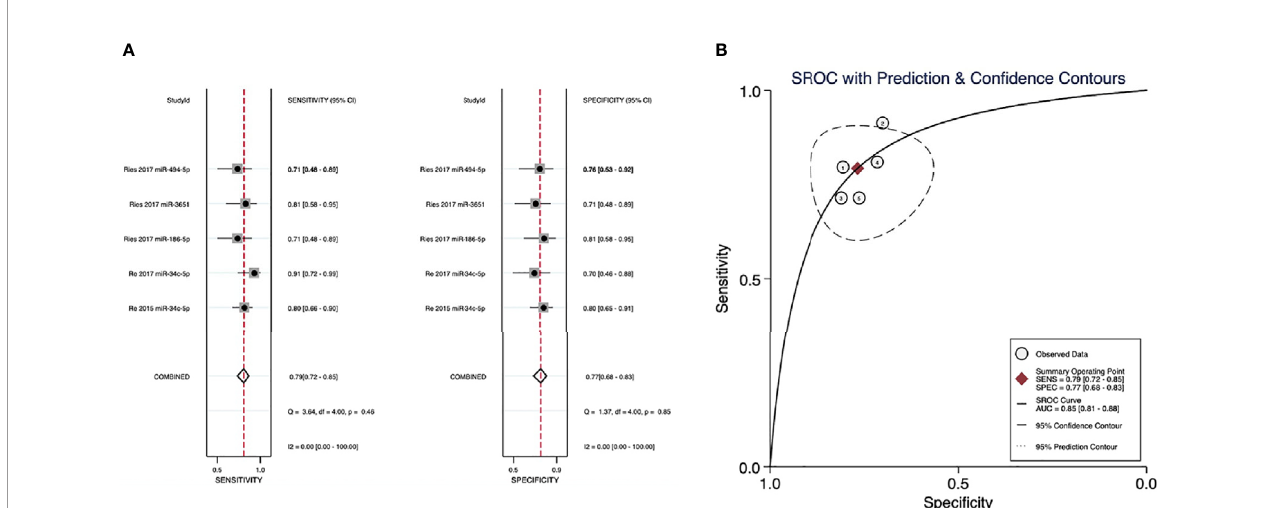
FIGURE 4 | (A) Sensitivity and speci fi city of microRNAs in diagnosing recurrence. (B) The summary receiver operating characteristic (SROC) curves of the diagnostic performance of microRNAs for